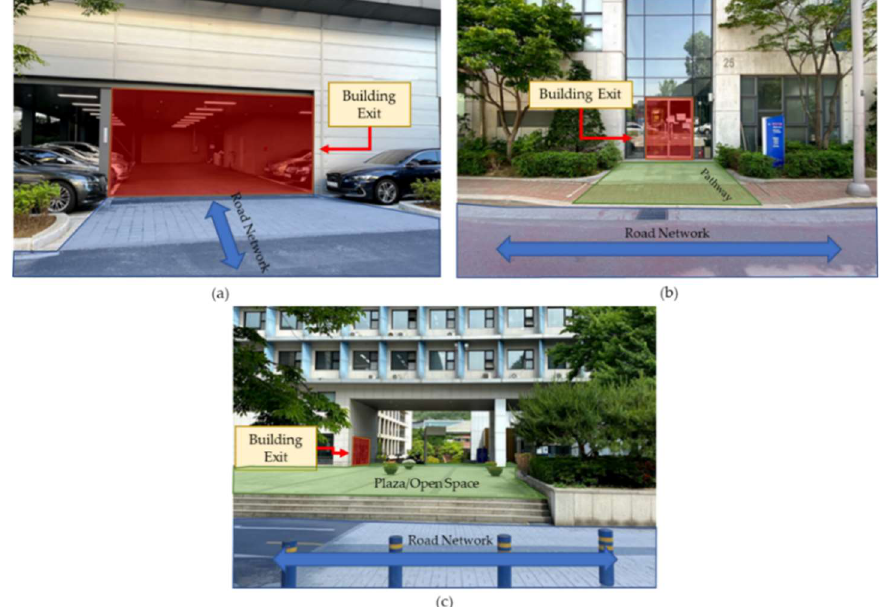
Figure 3. Three cases of spaces in between indoor and outdoor space. Case 1 ( a ) shows exit points already in outdoor pedestrian networks, Case 2 ( b ) shows a road network immediately accessible to the building exit, and Case 3 ( c ) shows an open space in between the building exit and the road network.